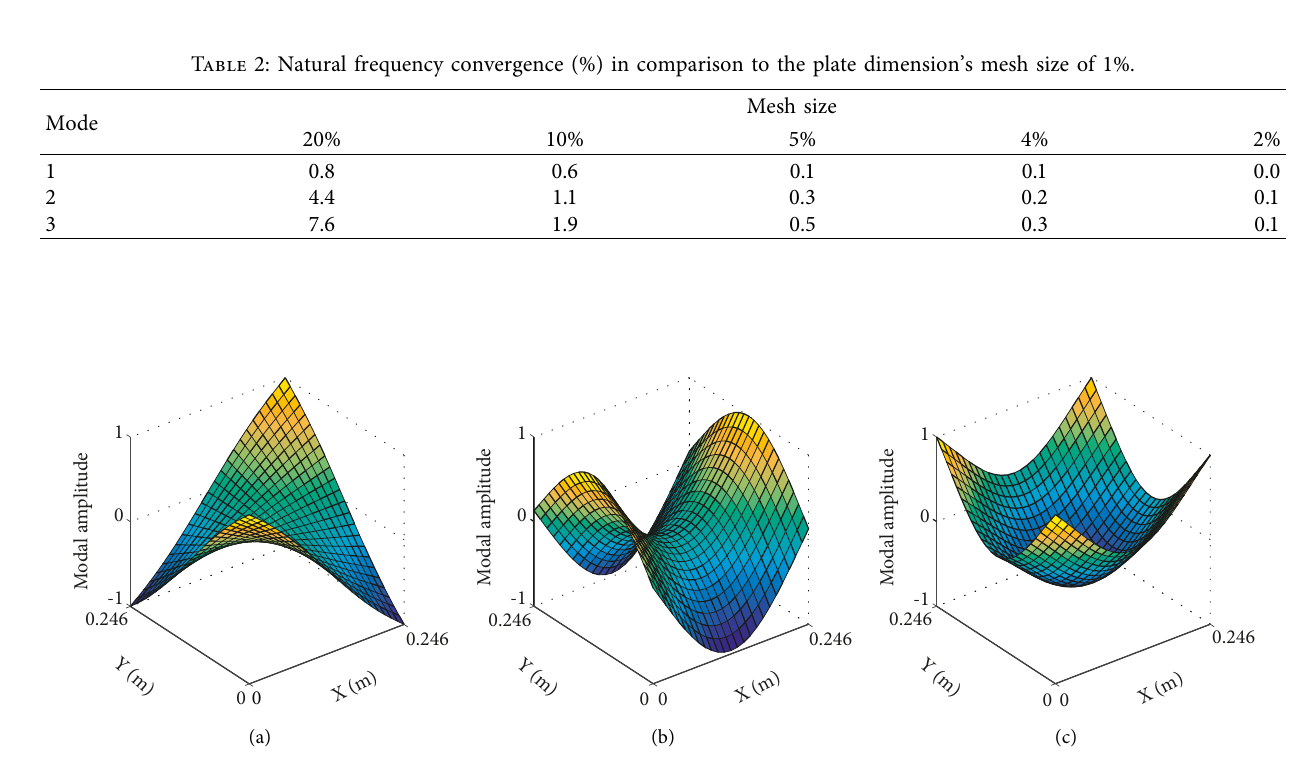
Figure 7: The first three flexural mode shapes of the free intact plate: (a) Mode 1, (b) Mode 2, and (c) Mode 3.